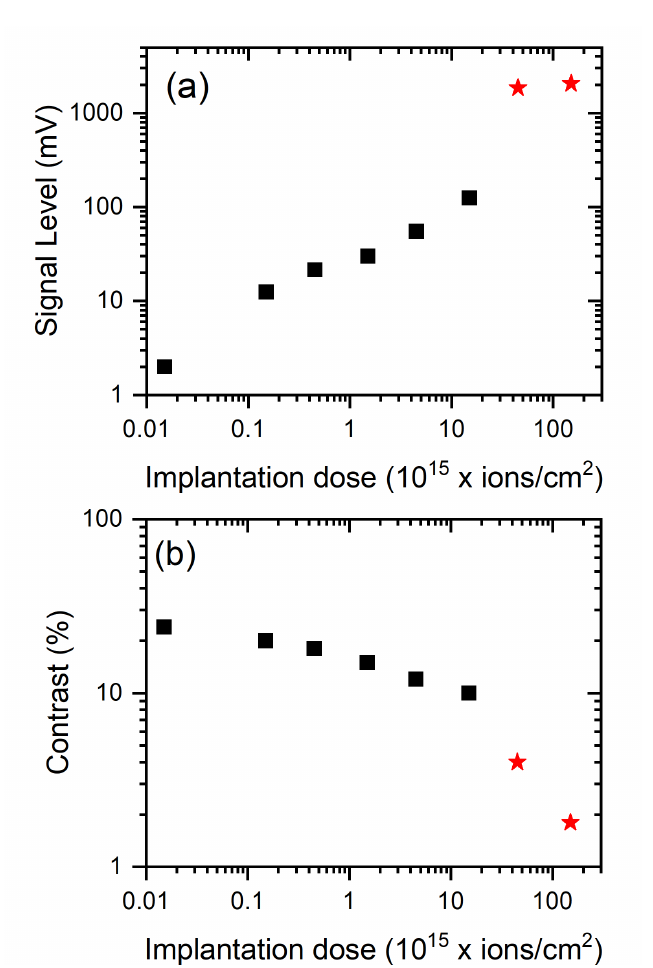
Figure 5. The fluorescence level from different spots versus the implantation dose of protons (black squares-HEN1, red stars-HEN2) ( a ) and the ODMR contrast versus an irradiation dose ( b